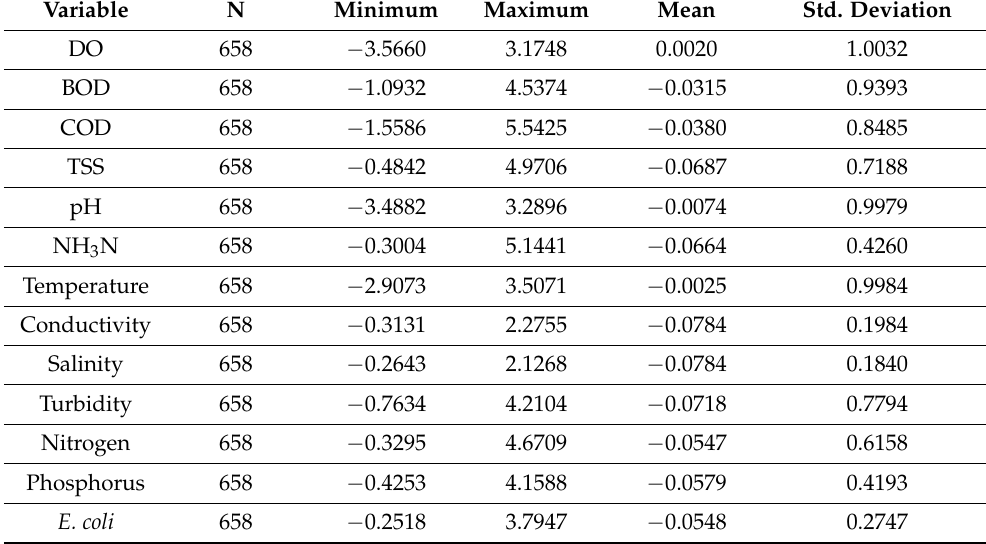
Table 6. Descriptive statistics for all predictor